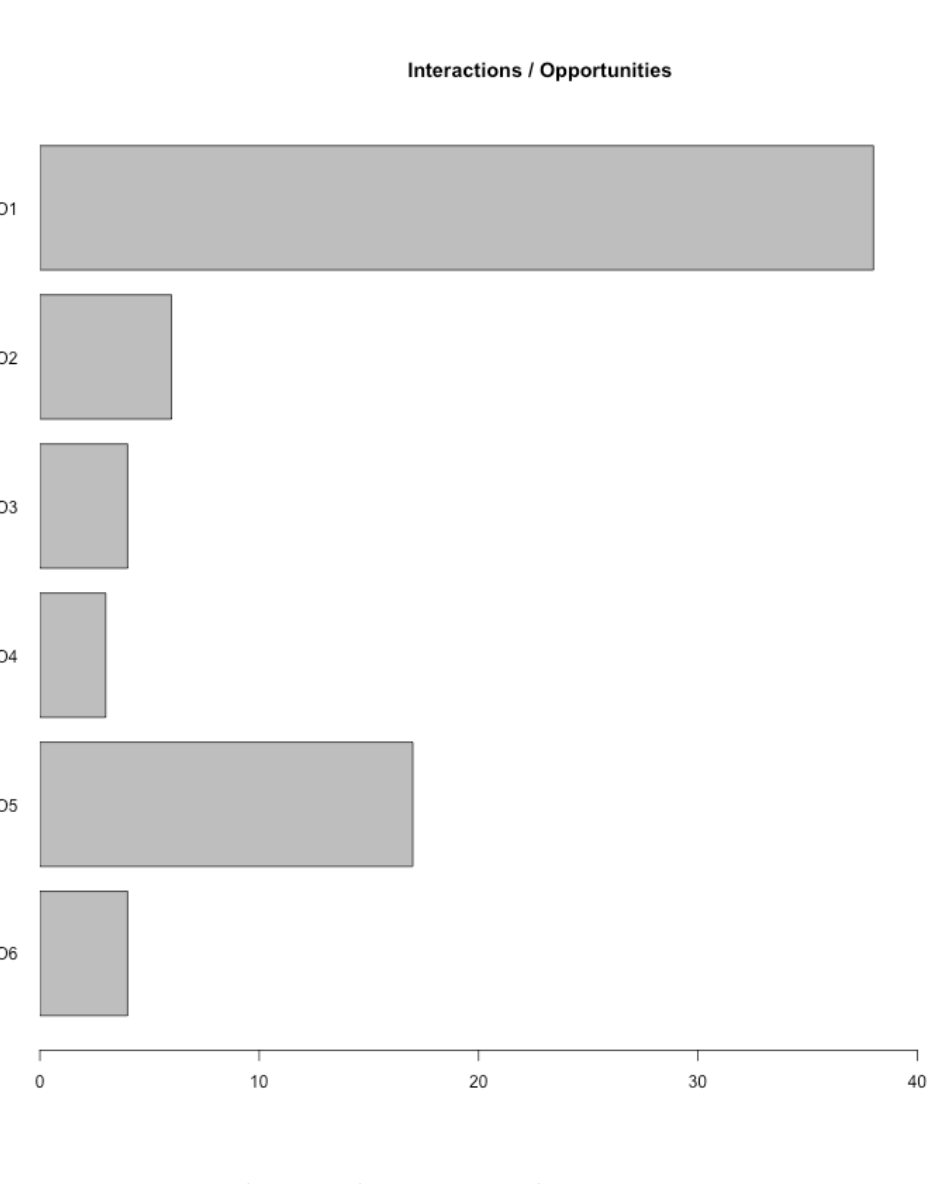
Figure A1.1: Number of models for each type of